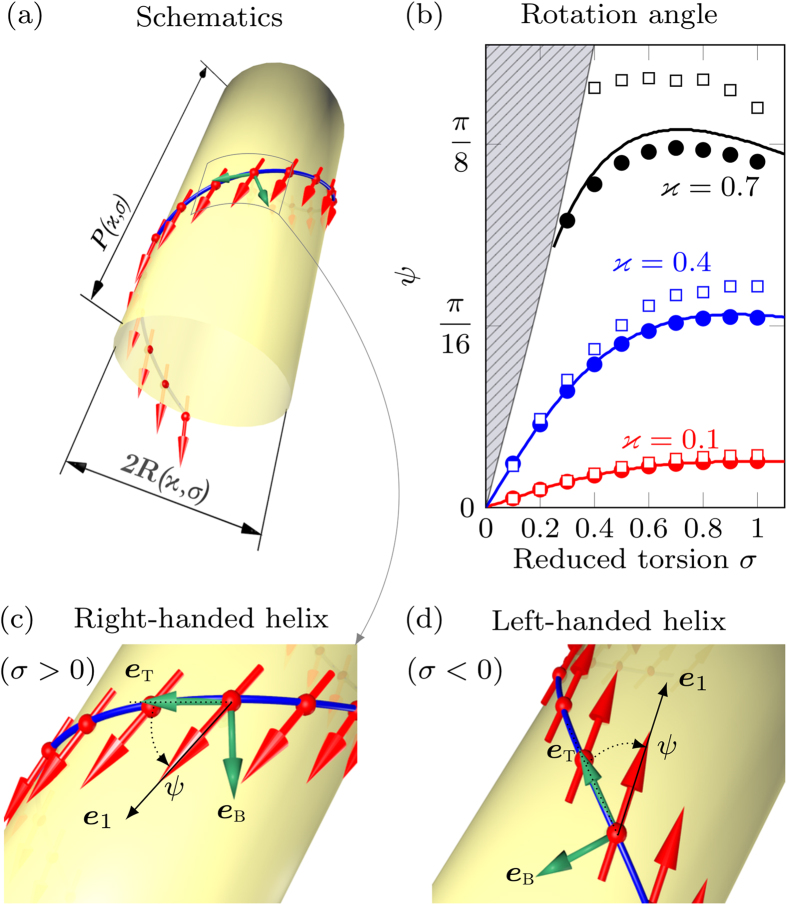
Magnetization distribution in a helix.(a) Schematics of magnetic helix with the easy-tangential anisotropy (magnetic moments are shown with red arrows, TNB-basis is shown with green arrows. (b) The rotation angle ψ for different torsions σ and curvatures ϰ. The onion state is energetically preferable in the grey region37. Solid lines correspond to analytics37, filled circles and open squares correspond to SLaSi and Nmag simulations, respectively; see Methods for details. (c,d) Discrete magnetic moments at equilibrium for right- and left-handed helices, respectively. The effective anisotropy axis is shown with thin black arrow e1.